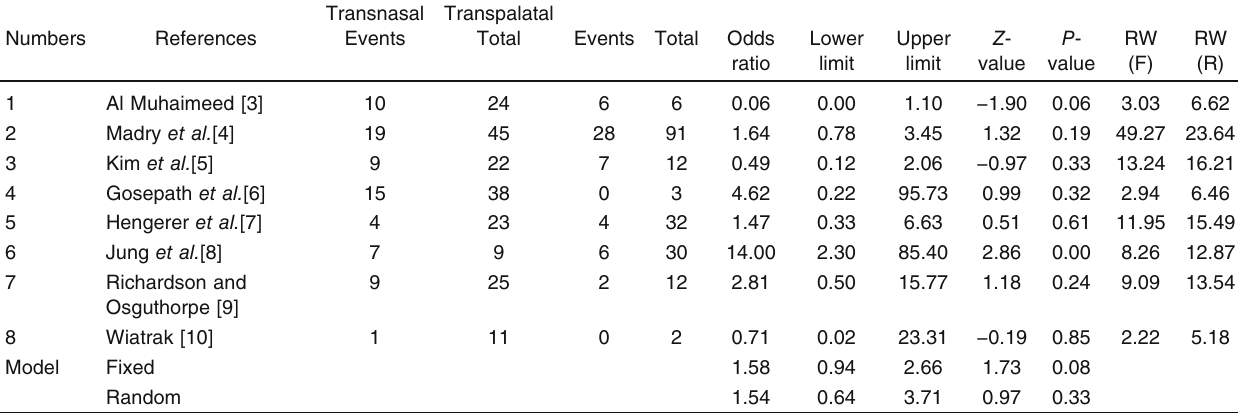
Table 3 Meta-analysis for the incidence of restenosis after transnasal or transpalatal repair using the estimated odds ratio as the effect measure